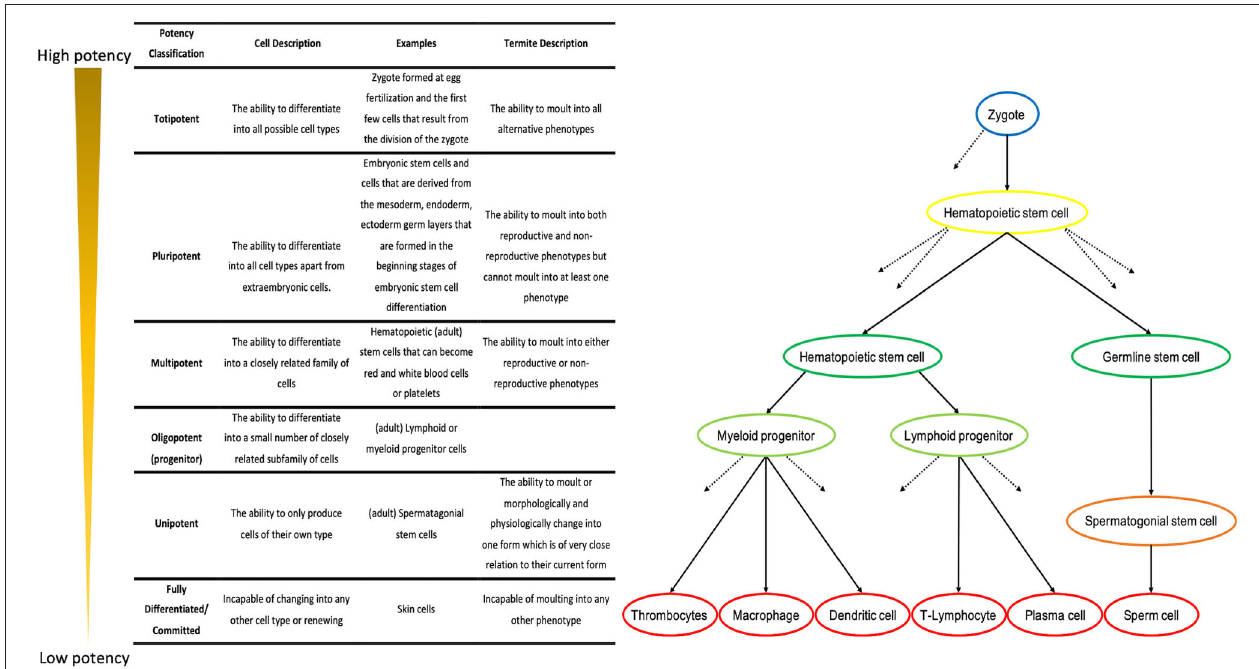
FIGURE 2 | Terminology used to describe levels of potency within cells with examples, adapted from (Kalra and Tomar, 2014), and simplified cellular developmental pathway showing the different levels of developmental plasticity. Everything but the zygote and embryonic stem cells are cells in an adult mammal. Full arrows, pathway from one cell type to another; dashed arrows, presence of other pathways not shown. Blue, Totipotent; Yellow, Pluripotent; Green, multipotent; Light Green, Oligopotent (progenitor); Orange, Unipotent; Red, fully differentiated.